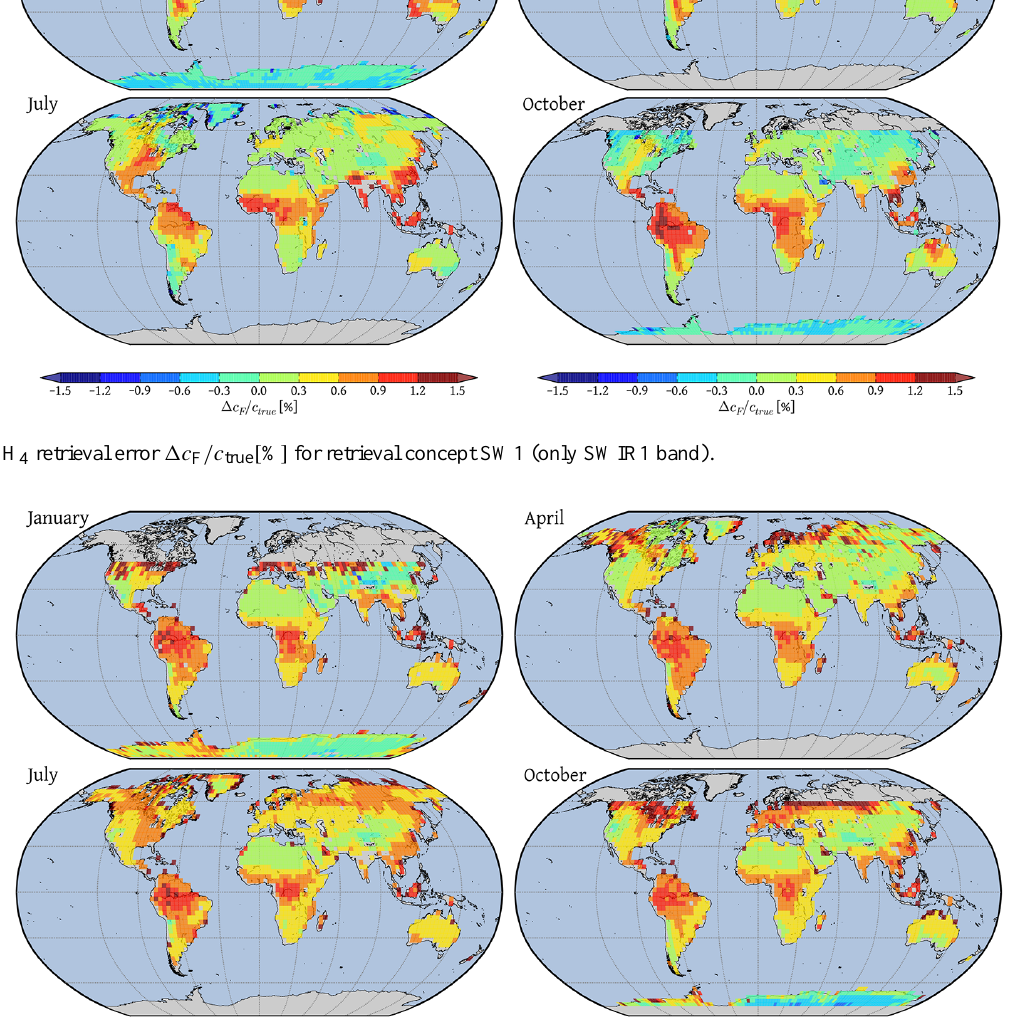
tens ppb, which is relevant in the view of S5’s and S5P’s error